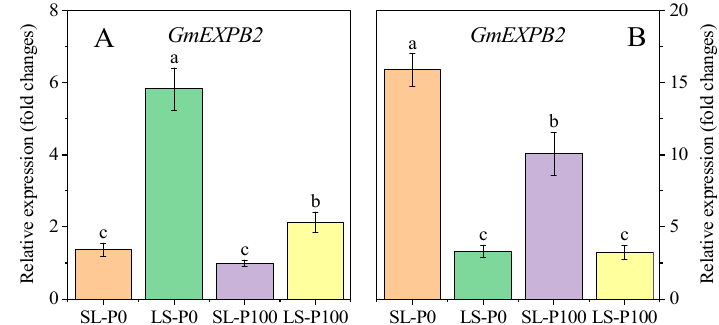
Figure 4. The effect of P application and light condition on the expression of gene GmEXPB2 in roots (( A ): V5 stage, ( B ): R3 stage) in the pot experiment. Plants were grown in two light conditions (SL: shade from sowing to the V5 stage and from V5 to R8 under natural light condition; LS: from sowing to the V5 stage under natural light condition and shade from V5 to R8) and two P application treatments (P0 = without P application; P100 = 100 mg P kg − 1 soil application). Values represent the mean of three replicates ± SE. Different letters on the columns are used to indicate means that differ significantly by LSD ( p ≤ 0.05). For GmEXPB2 expression, data are expressed as relative values based on the expression of GmEXPB2 in roots of soybean grown under the treatment of SL-P100 at V5 stage referenced as 1.0.